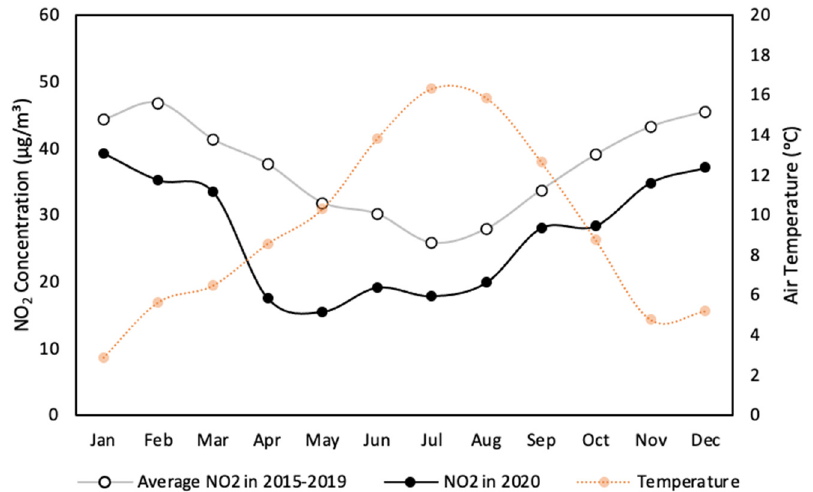
Figure 5. NO 2 concentrations and air temperatures in Manchester.